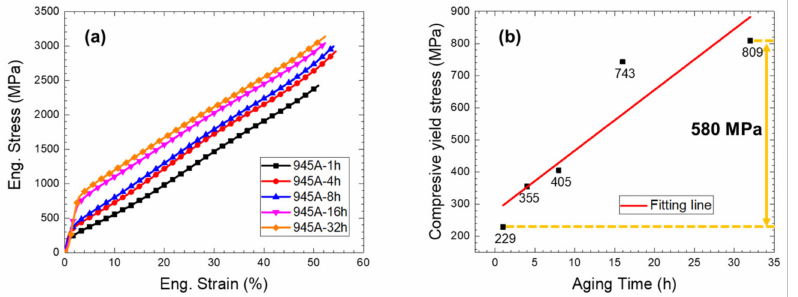
Figure 1. The compressive properties of the 945A Ni-based superalloys. ( a ) Compressive curves, and ( b ) the compressive yield stress vs. aging time distribution